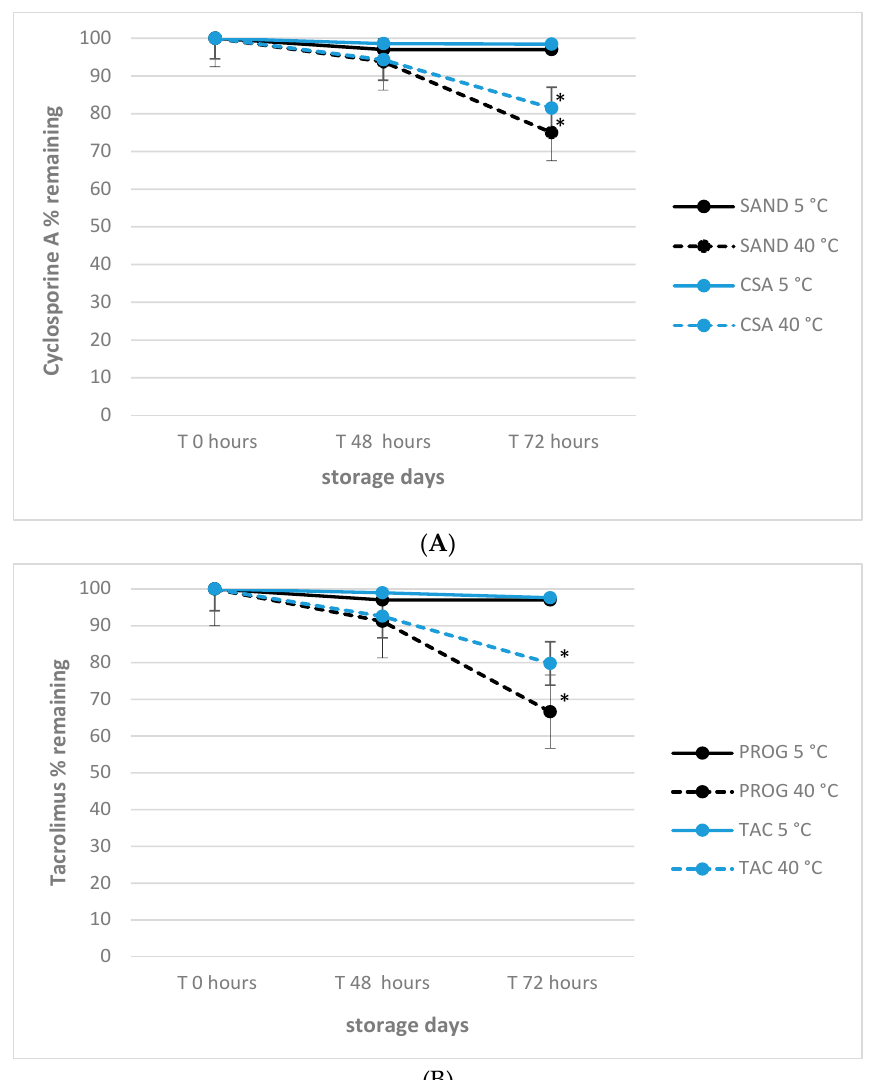
Figure 6. ( A ) E ff ect of delivery simulated conditions on 1.0% cyclosporine A stability in commercial and experimental eye drops formulations; * p < 0.05, T.amb versus 5 ◦ C storage temperature. ( B ) E ff ect of delivery simulated conditions on 0.1% tacrolimus stability in commercial and experimental eye drops formulations; * p < 0.05, T.amb versus 5 ◦ C storage temperature.